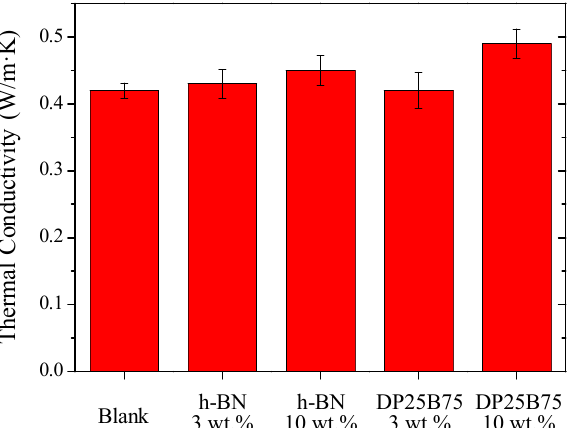
Figure 8. Thermal conductivity of BB creams with or without h-BN and DP25B75 powder.